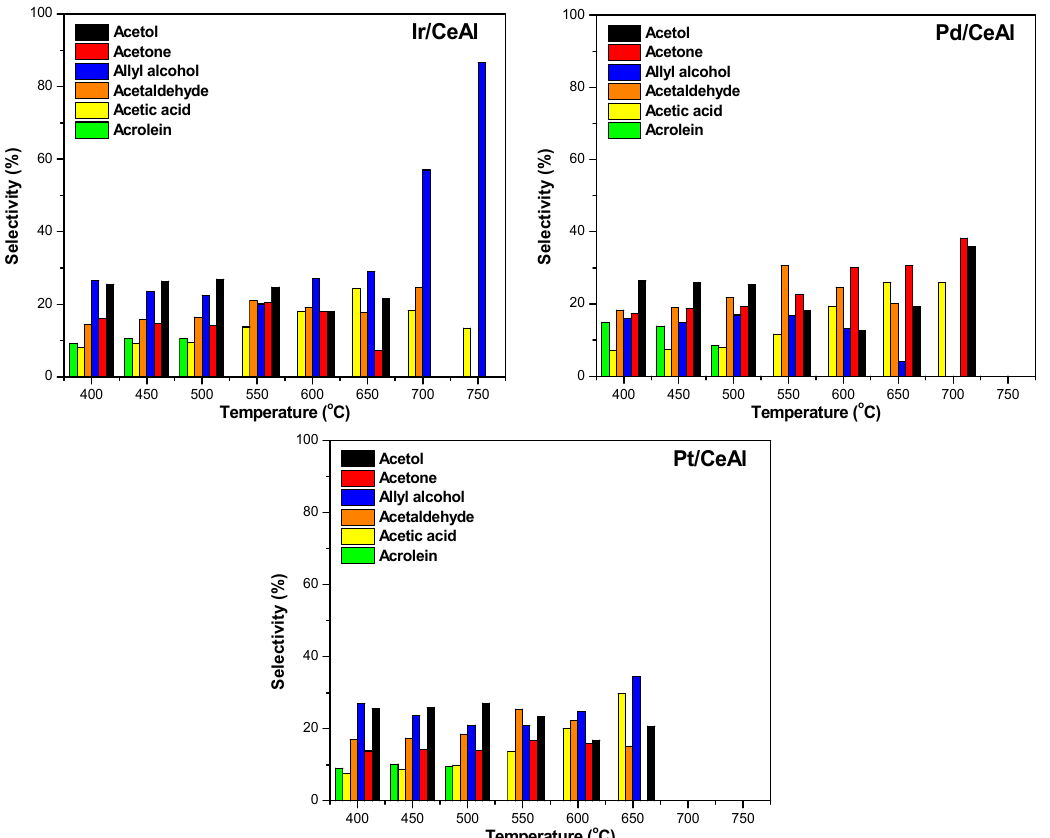
Figure 8. Selectivity of liquid phase products for the Ir/CeAl, Pd/CeAl and Pt/CeAl catalysts (activity experiments).